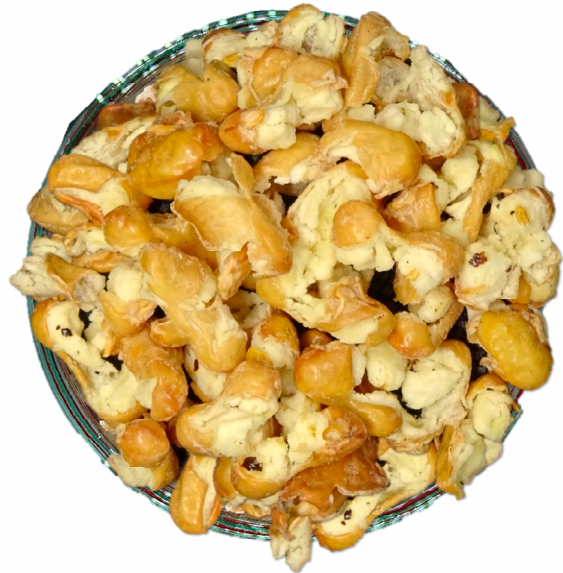
Figure 1. Common bean baked snack.